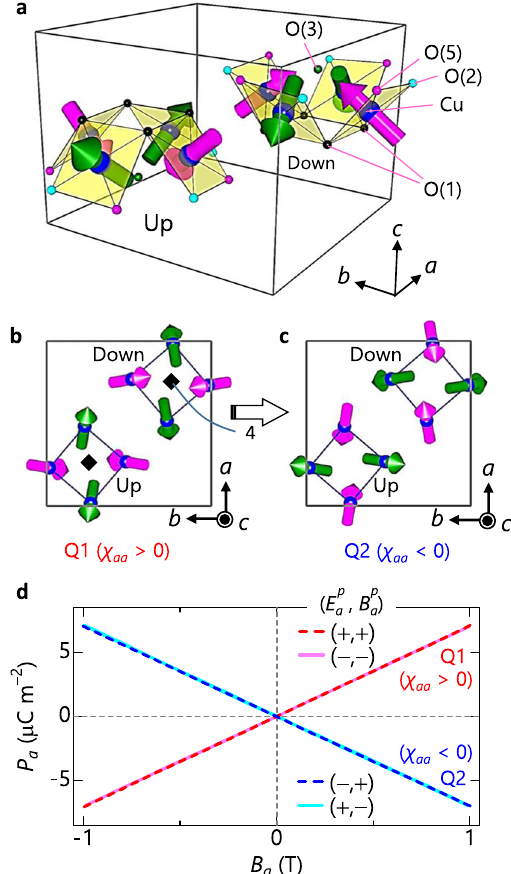
Fig. 2 Magnetic structure and domains in the antiferromagnetic phase of Pb(TiO)Cu 4 (PO 4 ) 4 . a A bird ’ s eye view of the crystal and magnetic structures. Pb, Ti, and P atoms are omitted. A unit cell (solid line) contains one upward and one downward Cu 4 O 12 square cupola each formed by four Cu 2 + ions (large blue balls) and twelve O 2 − ligands (small balls). Magenta and green arrows represent inward and outward pointing Cu 2 + spins on the square cupolas, respectively. The c -axis views of the magnetic structures in b Q1 and c Q2 quadrupole domains, which are mutually converted by either fourfold-rotation (4) or time-reversal operations. The ME coef fi cient χ aa in these two domains is opposite in sign to each other. d Electric polarization along the a axis as a function of magnetic fi eld along the a axis at 3 K, measured after cooling with four different sign combinations of poling electric ( E p a ¼ ± 0 : 83 MV m − 1 ) and magnetic fi elds along the a axis ( B p a ¼ ± 0 : 1